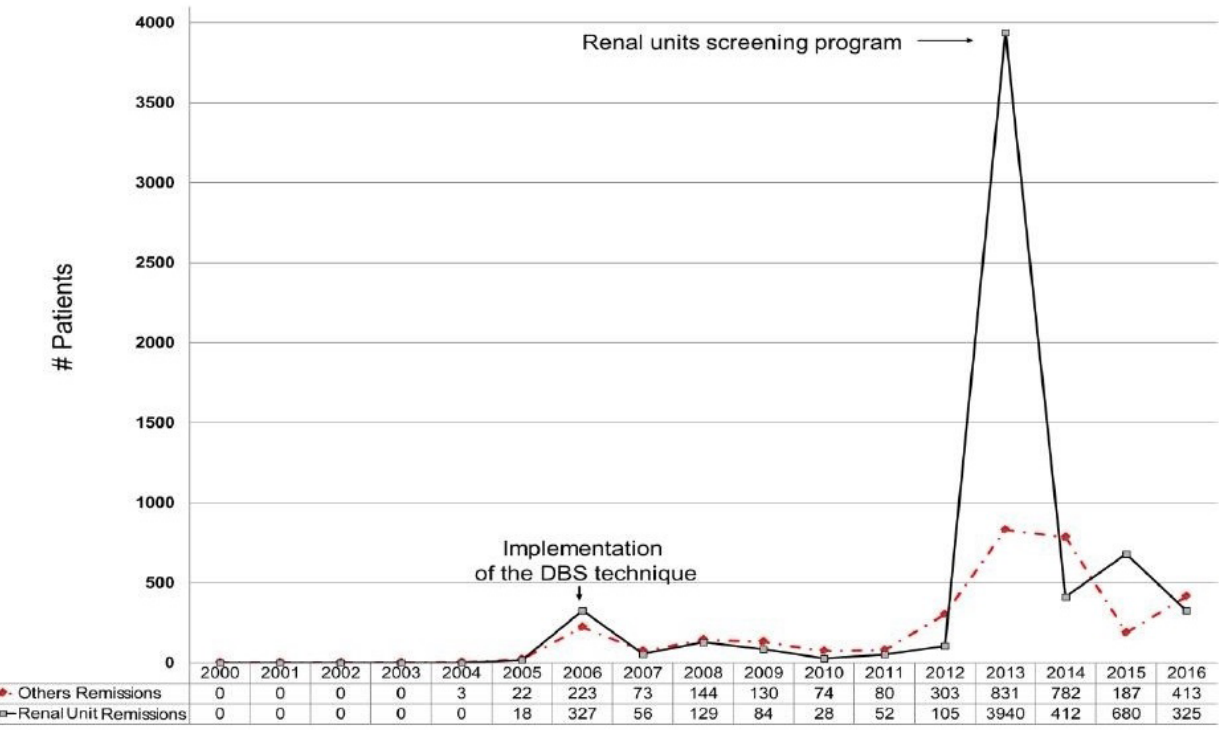
Figure 2. Increase in the number of patients referred for clinical suspicion of Fabry disease due to DBS screening methods in a high-risk population. Data for referrals from the Renal Unit are shown in black and all other referrals in